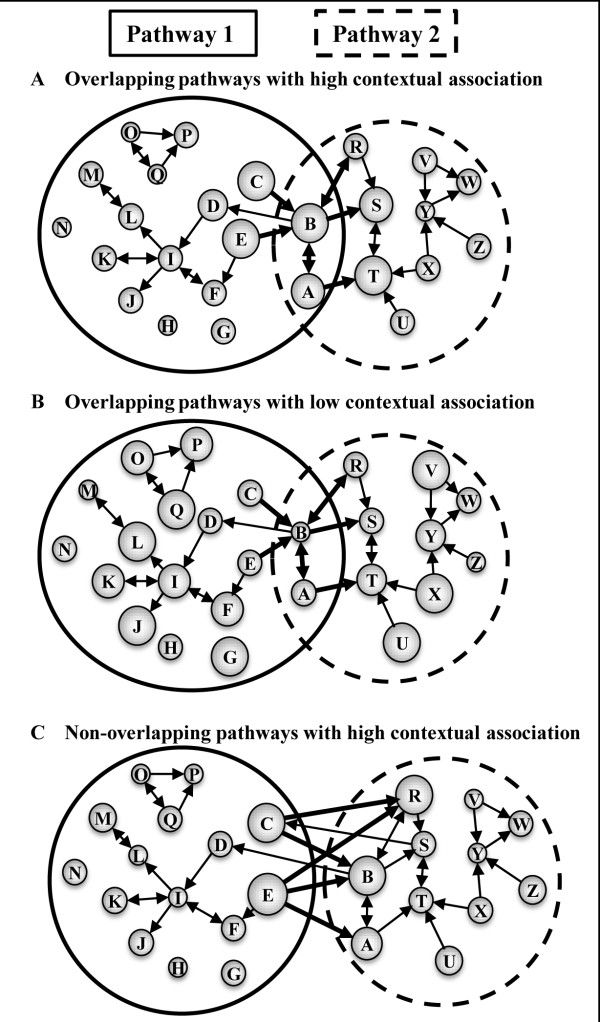
Schematic representation of three scenarios of contextual association between pathways. Each illustration (A-C) shows two pathways (sets of both connected and isolated genes inside ellipsoids) with varying degrees of overlapping genes. The size of the circles (genes) represents the level of differential gene expression between control and disease patients (the higher the significance associated with the expression change, the larger the circle). The lines and arrows represent KEGG-derived interactions between genes as annotated in the pooled pathway, and the thick lines represent edges connecting genes from Pathway 1 to Pathway 2. (A) Overlapping pathways with high contextual association. Whereas Pathway 1 and Pathway 2 can be associated because genes A and B are shared between the two pathways, the fact that overlapping genes are directly connected to other differentially expressed genes (thick connections to large circles) enhances this association. (B) Overlapping pathways with low contextual association. The pathway maps are exactly the same as in case (A). However, Pathway 1 is “less” associated with Pathway 2 in the context of gene expression data, as the genes connected by thick edges are modestly differentially expressed (thick connections to small circles). (C) Non-overlapping pathways with high contextual association. Although, Pathway 1 and Pathway 2 do not share any genes, genes from these two pathways are connected based on inter-pathway connectivity inferred from the pooled pathway. Pathway 1 is contextually associated with Pathway 2 because the genes connecting these two pathways are differentially expressed.